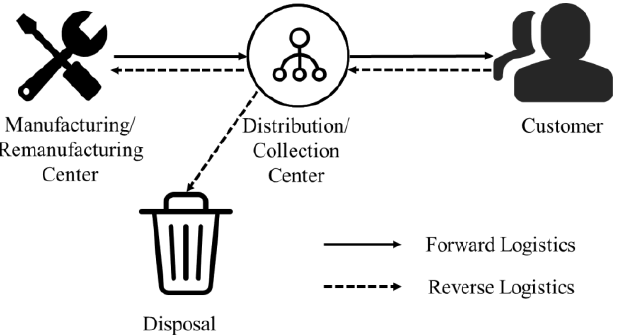
Figure 3. hybrid network structure. Figure 3. Hybrid network